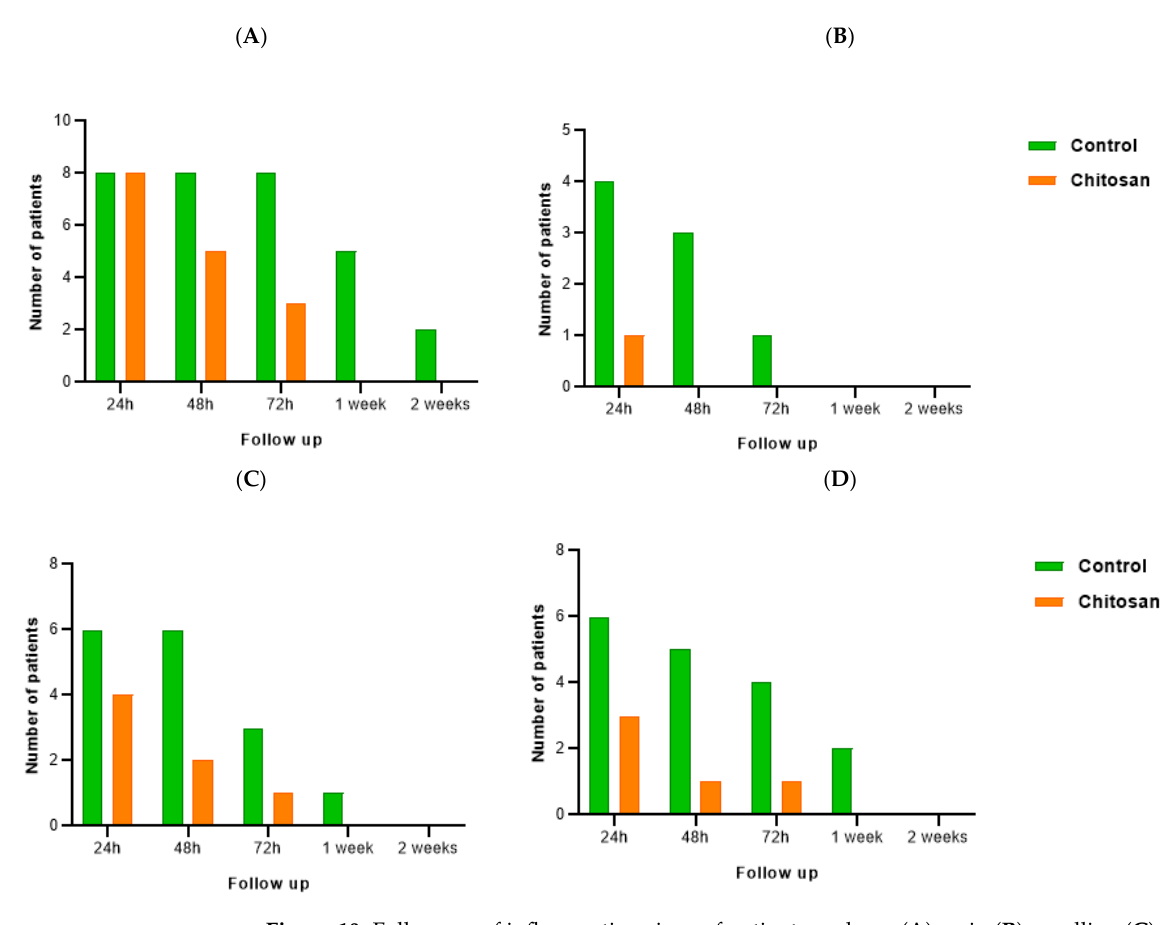
Figure 10. Follow-up of inflammation signs of patients: redness ( A ), pain ( B ), swelling ( C ), and loss of function ( D ) from the control group (non-chitosan sockets) and the experimental group (subjected to the application of chitosan). Redness was examined through the color of the oral mucosa; pain intensity was recorded using VAS; the shape of the face/mandibular angles was inspected for swelling evaluation; and loss of function was determined if the patient had restriction of the range of motion of the